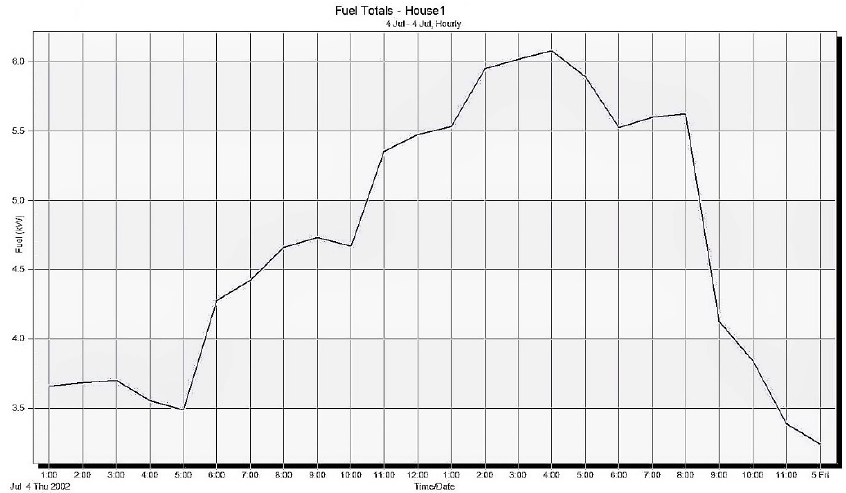
Figure 11. The simulation of electricity consumption of House 1 on a typical summer day (4 July) under the continuous mode.